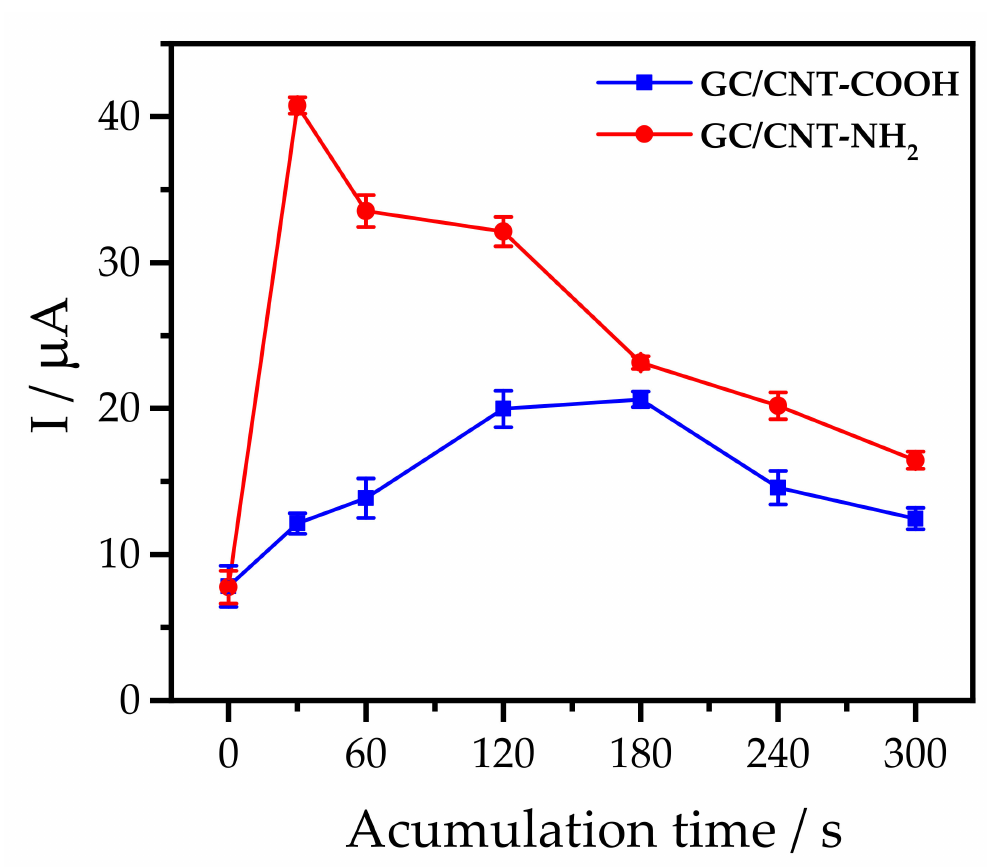
Figure 2. Effect of accumulation time on the oxidation current intensity of 0.1 mM HQ for the GCE/MWCNT-COOH and GCE/MWCNT-NH 2 systems. Working conditions: Scan speed 50 mV/s, Electrolyte: Buffer Britton–Robinson 0.1 M, pH